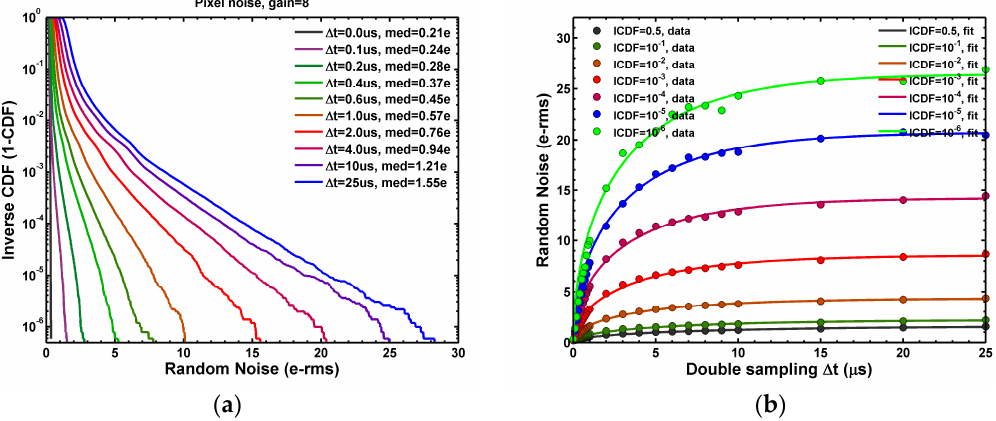
Figure 13. ( a ) The family of the ICDF (inverse CDF) curves of the RN distribution when Δ t is gradually increased from 0 to 25 μ s; ( b ) The family of the constant-ICDF contours at ICDF = 0.5, 10 − 1 , 10 − 2 , 10 − 3 , 10 − 4 , 10 − 5 , and 10 − 6 , respectively. The contours were fit to the analytical Formula (4).